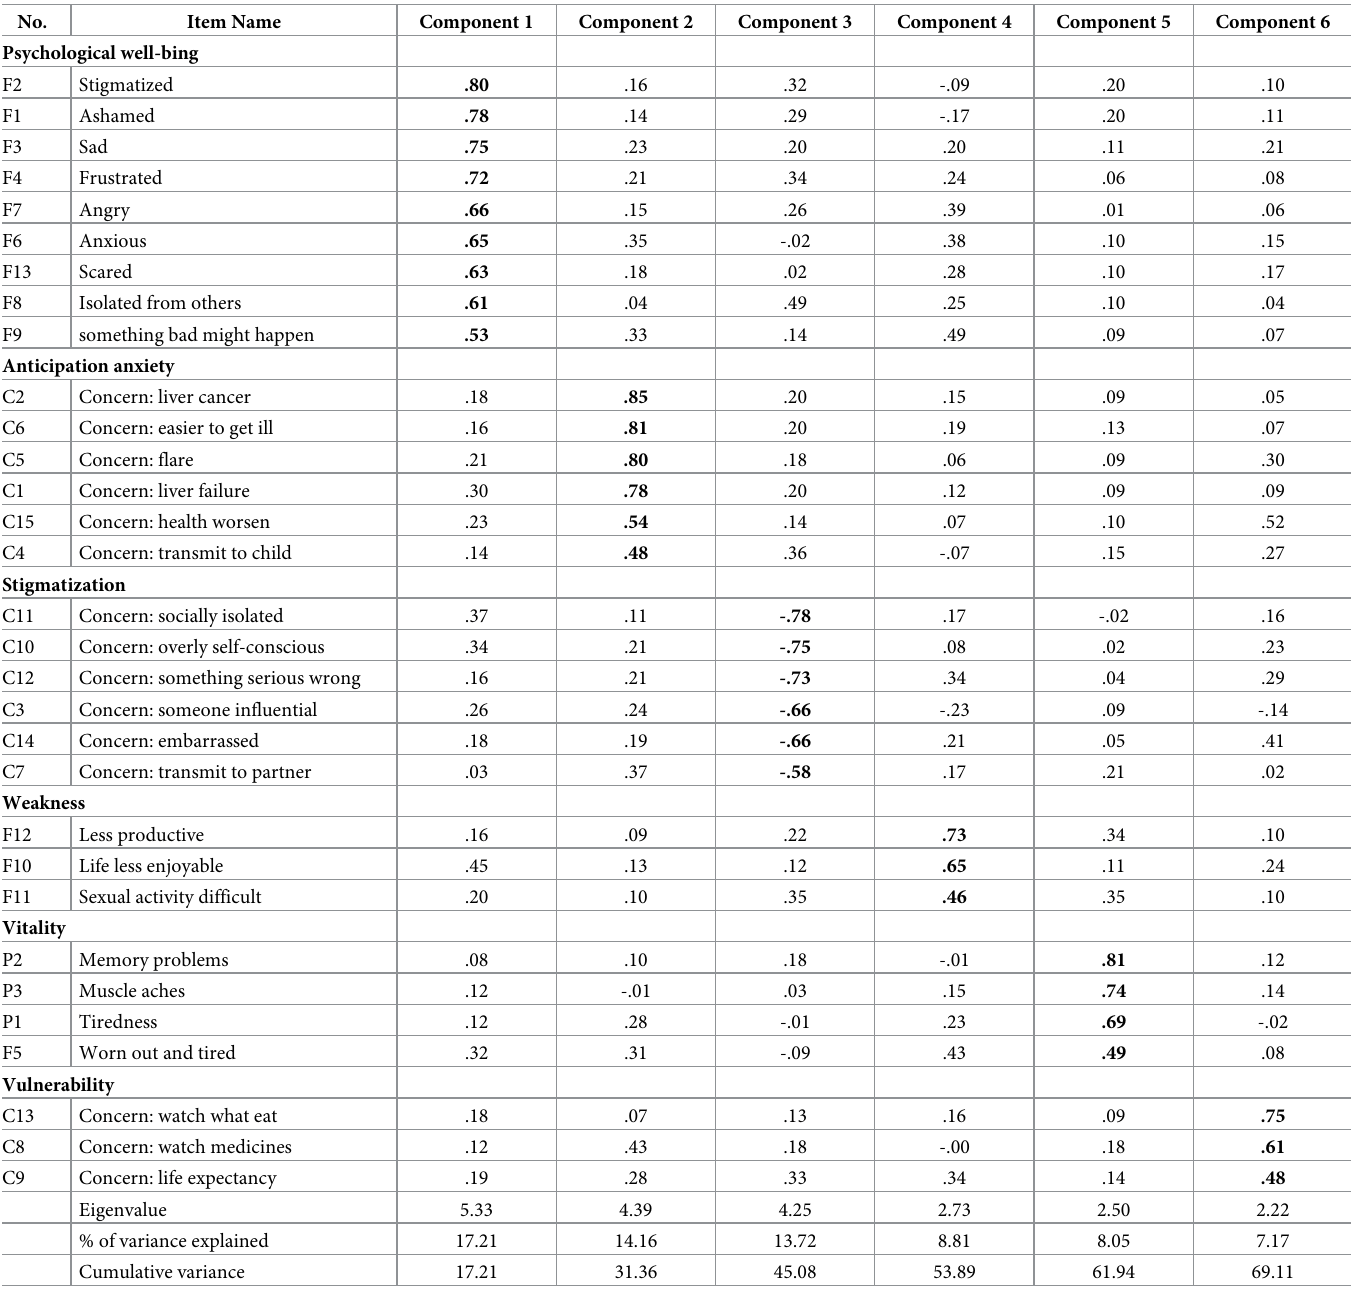
Table 3. Components loadings for K-HBQOL (N =